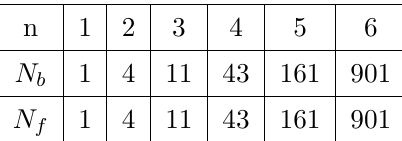
Table 1 . The number of bosonic N b or fermionic N f gauge invariant tensors constructed using n (cid:12)elds. This counting is for gauge group ranks N 1 = N 2 = N 3 = 1